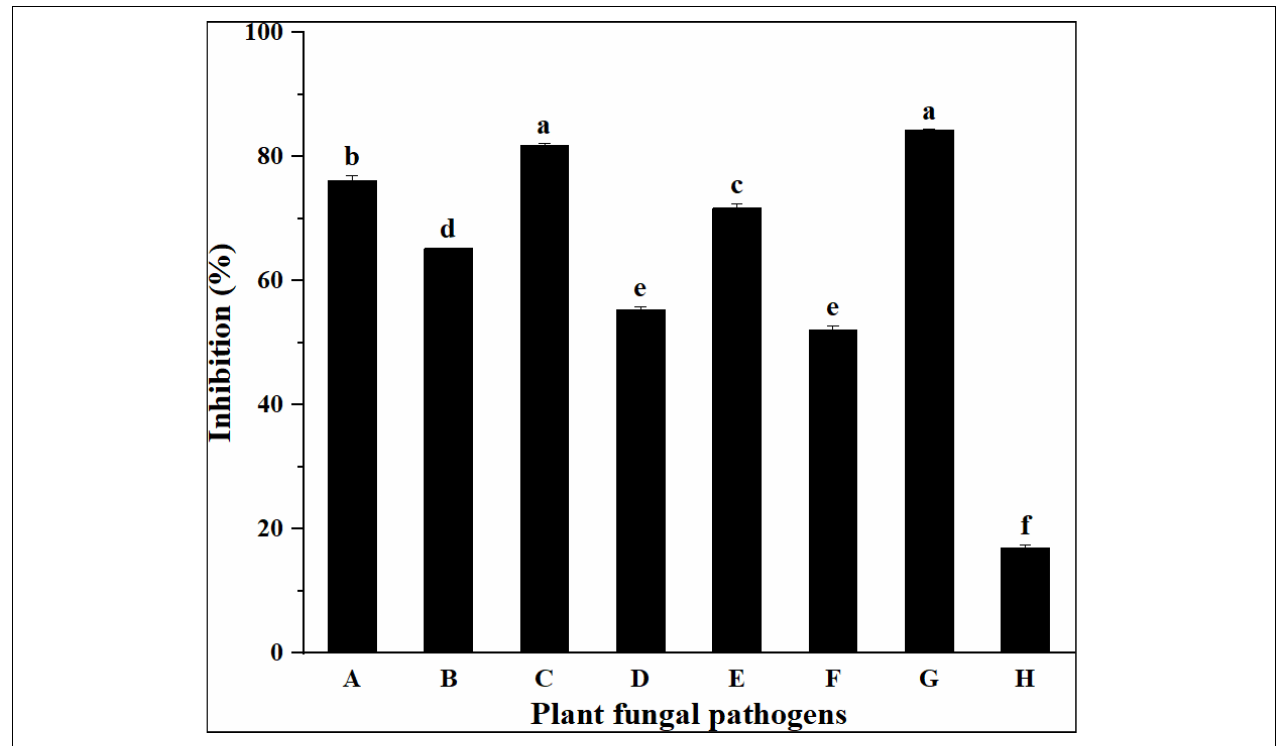
FIGURE 2 | Inhibition activities of strain YC-9 against plant fungal pathogens. A: F. oxysporum f. sp. vasinfectum ; B: A. solani ; C: C. graminicola ; D: C. lunata ; E: C. cassiicola ; F: F. oxysporum f. sp. mornordicae ; G: B. cinerea ; H: F. graminearum . Bars with the same letters are not significantly different according to Duncan’s multiple range test at P < 0.05. Error bars represent the standard deviation from three replicates.